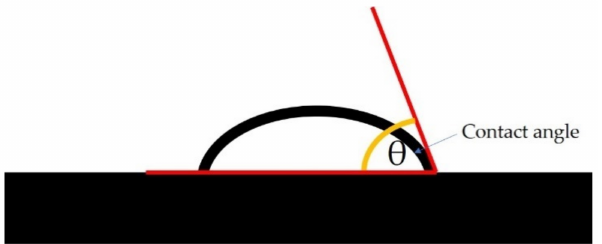
Figure 1. Schematic diagram demonstrating the contact angle